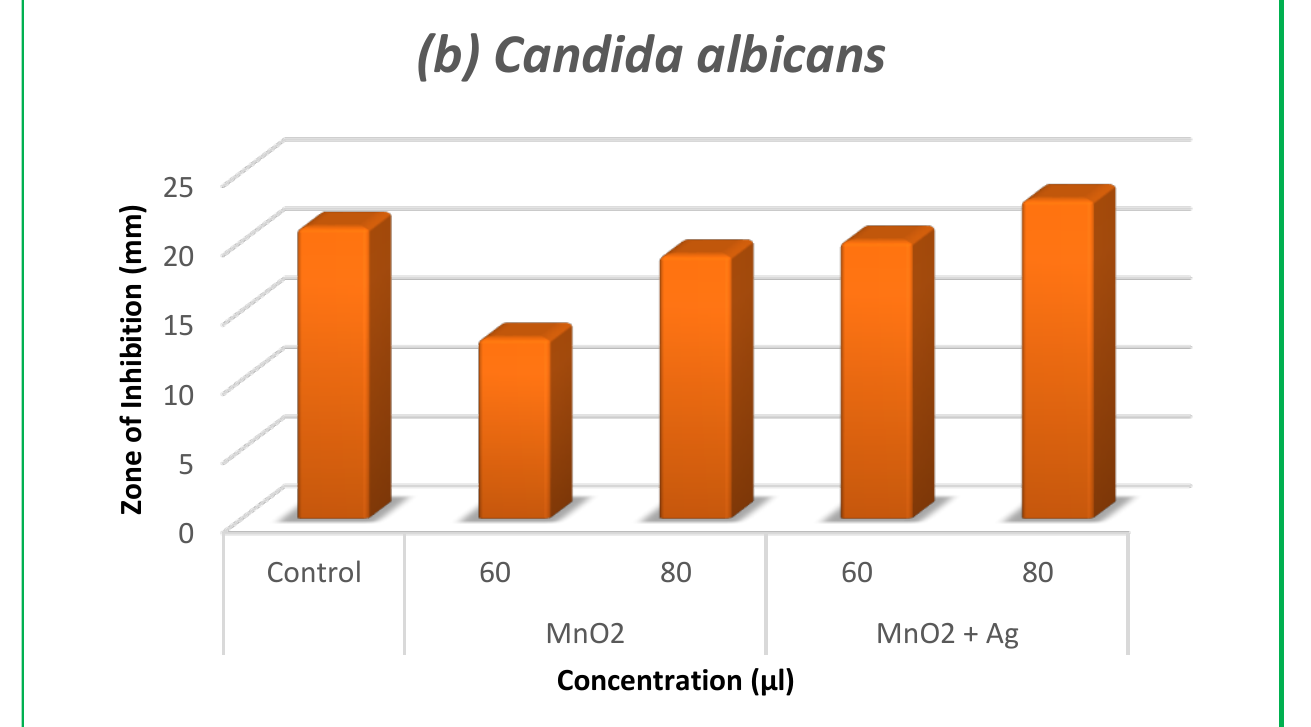
Figure 13. Zone of inhibition of MnO 2 doped with Ag nanoparticles against ( a ) Aspergillus niger and ( b ) Candida albicans stains. Table 1. Antibacterial and Antifungal activity of MnO 2 doped with Ag against Escherichia coli , Bacillus subtilis , Aspergillus niger and Candida albicans strains.